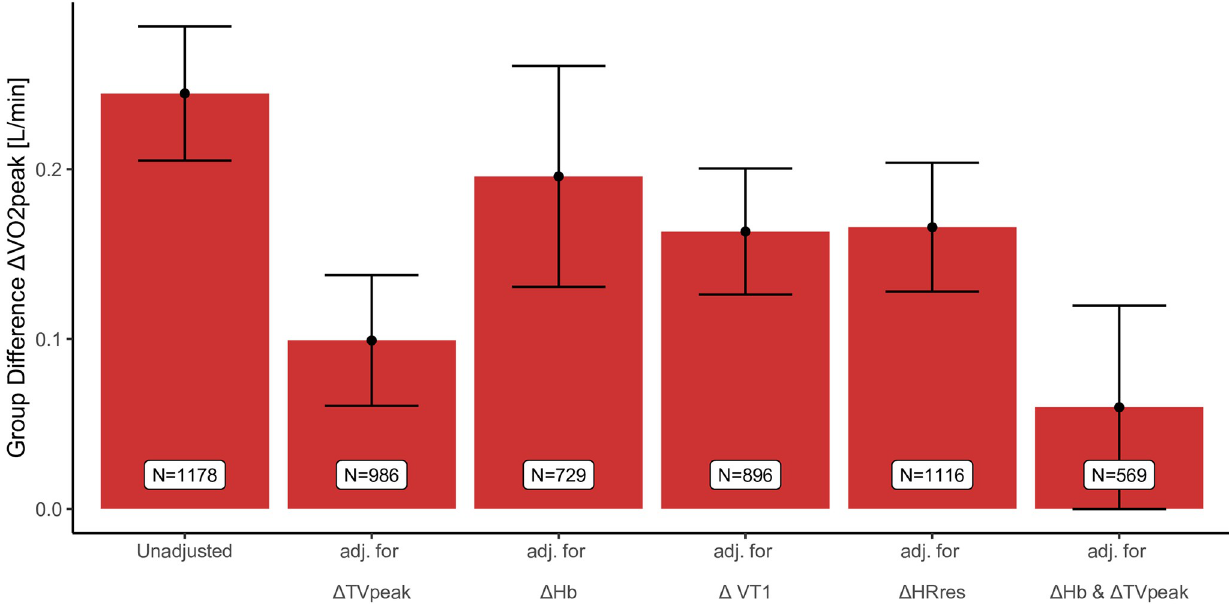
Fig 3. Mean differences (99%CI) in Δ peak VO2 [ml/kg/min] between surgery and non-surgery patients when adjusted for respiratory and circulatory/peripheral CPET parameters. adj., adjusted; VO2, oxygen consumption; TV, tidal volume; Hb, haemoglobin; VT, ventilatory threshold; HRres, heart rate